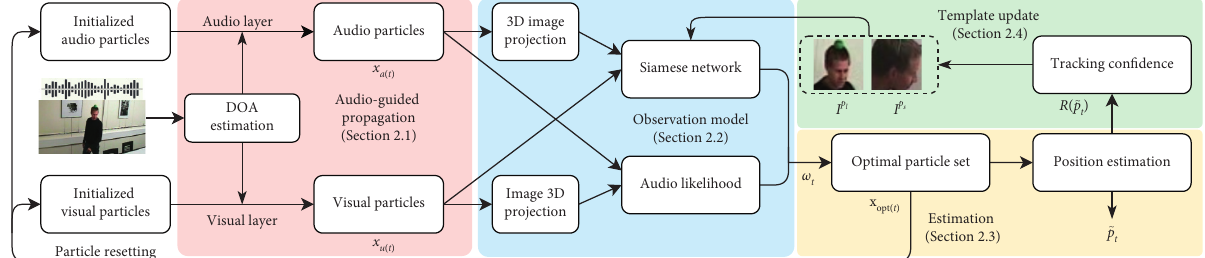
Figure 1: Overall framework of the proposed 3D audio-visual speaker tracking